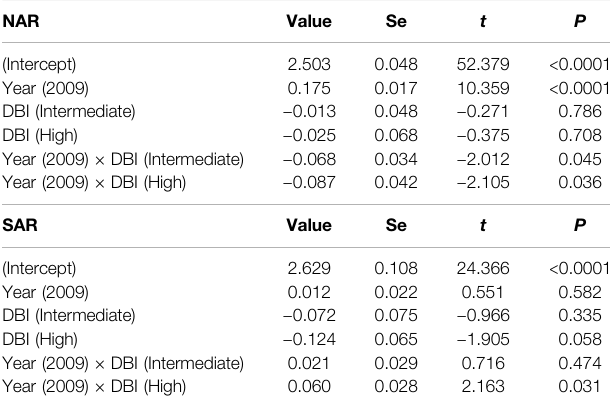
TABLE 3 | Summary statistics of the generalized least squares model assessing thedifferenceinthehumanfootprintindex(HFI)between1993and2009inthe surveyedlocalitiesofodonateassemblageswithvaryingDBIlevelsinNorthAfrican and South African regions. Year 1993 and low DBI are used as baseline levels. R-squared was 0.02 in NAR and 0.01 in SAR. To meet the model assumptions, HFI was log